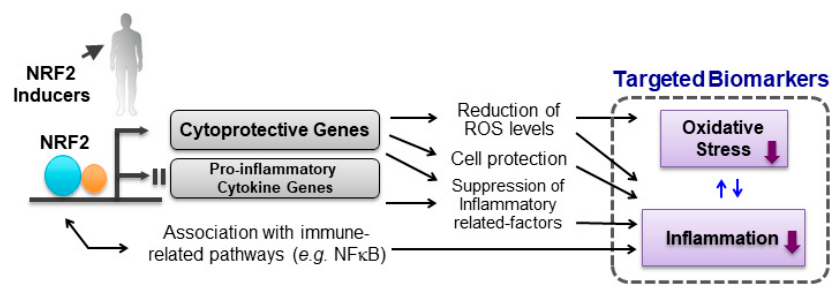
Figure 3. NRF2 signaling pathway and biomarkers targeting oxidative stress and inflammation. ROS, reactive oxygen